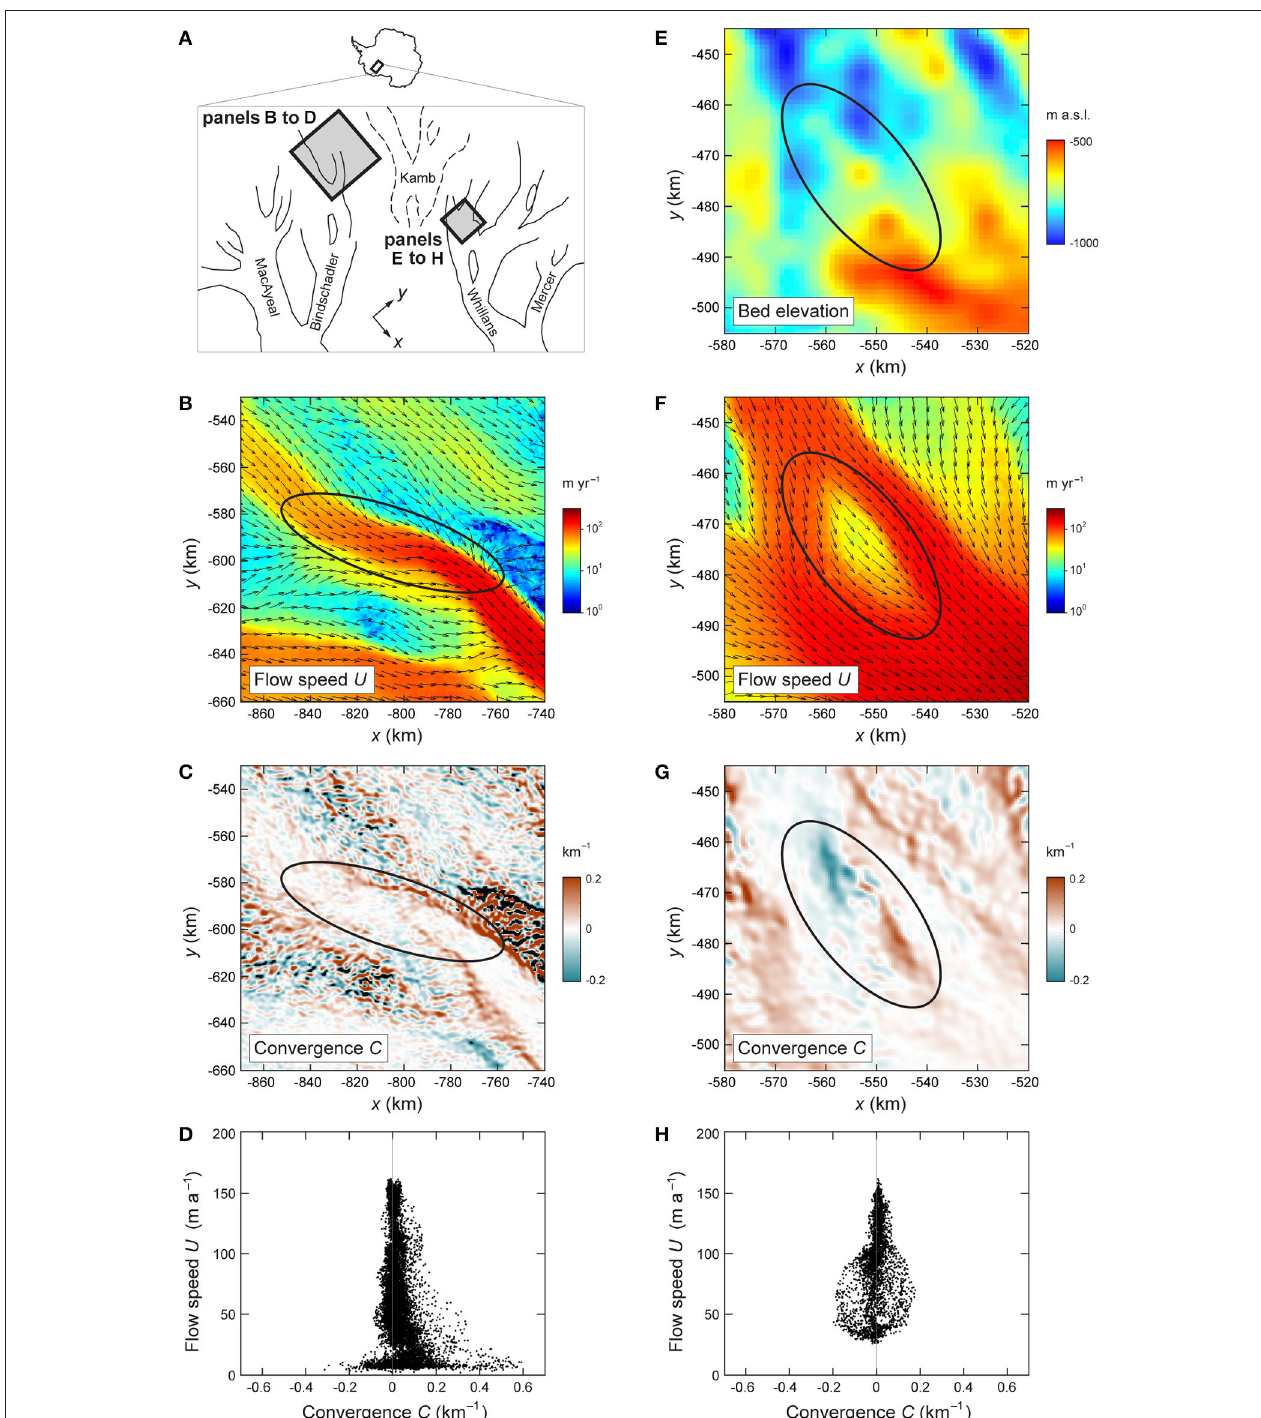
FIGURE 4 | Two types of flow structures on ice streams and their speed–convergence ( U – C ) signatures. (A) Map of ice streams along West Antarctica’s Siple Coast, locating the areas studied in the later panels. Panels (B–D) pertain to a fast-flow onset zone on Bindschadler Ice Stream. Panels (E–H) pertain to an upstream region of Whillans Ice Stream. (B,F) Surface flow speed U and flow-direction unit vectors derived from the dataset of Rignot et al. (2011). (E) Bed elevation from Bedmap2 (Fretwell et al., 2013). (C,G) Flow convergence C from Ng’s (2015) dataset. (D,H) Plots of U against C for the areas enclosed by ellipses in (B–C) and (E–G) , respectively. Both plots are located well within and near the base of the tower distribution in Figure 3A